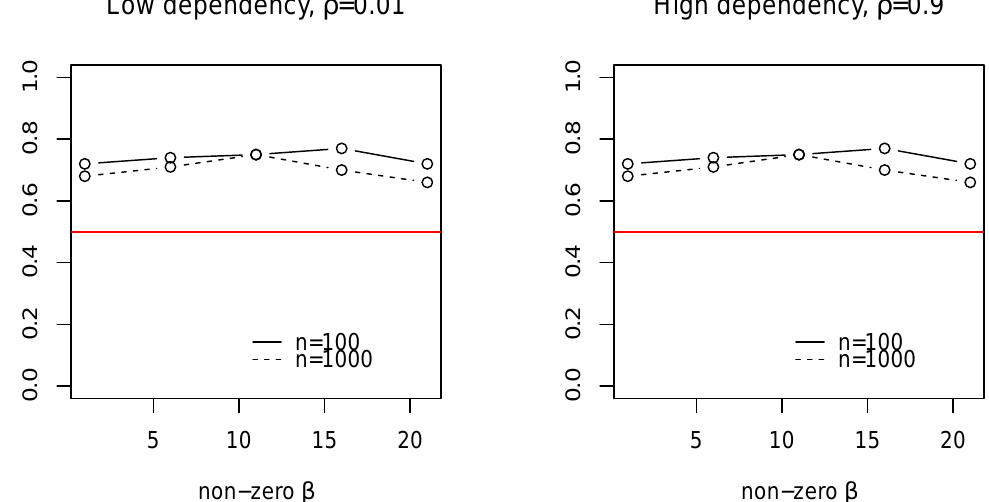
Figure 1. Probability that model with λ min outperforms model with λ 1 se for estimation.